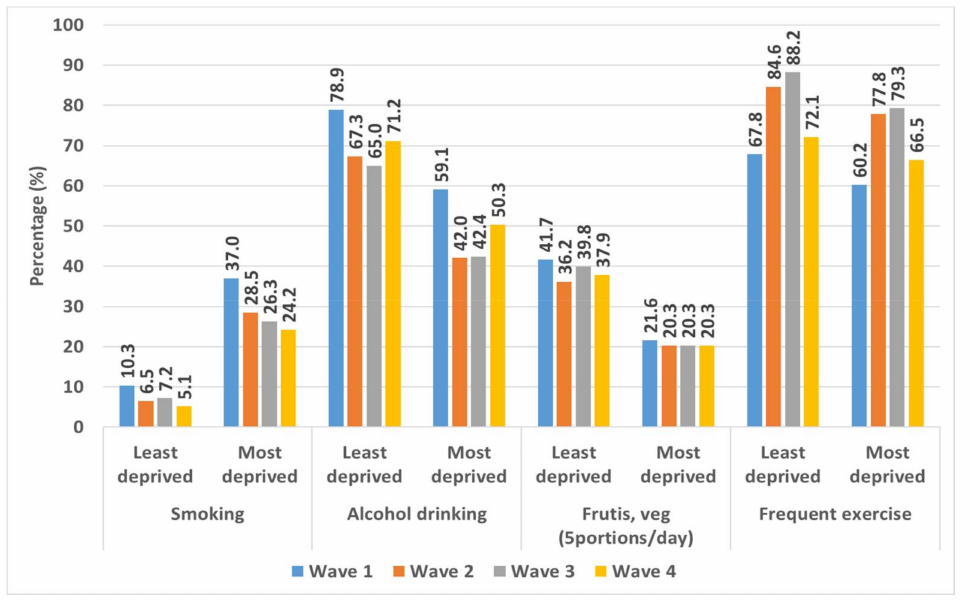
Figure 3. Percentage of respondents smoking, drinking alcohol, eating fruit and vegetables (five portions/day), and exercising frequently in the most- and least-deprived areas of Stockton-on-Tees, over four waves (18